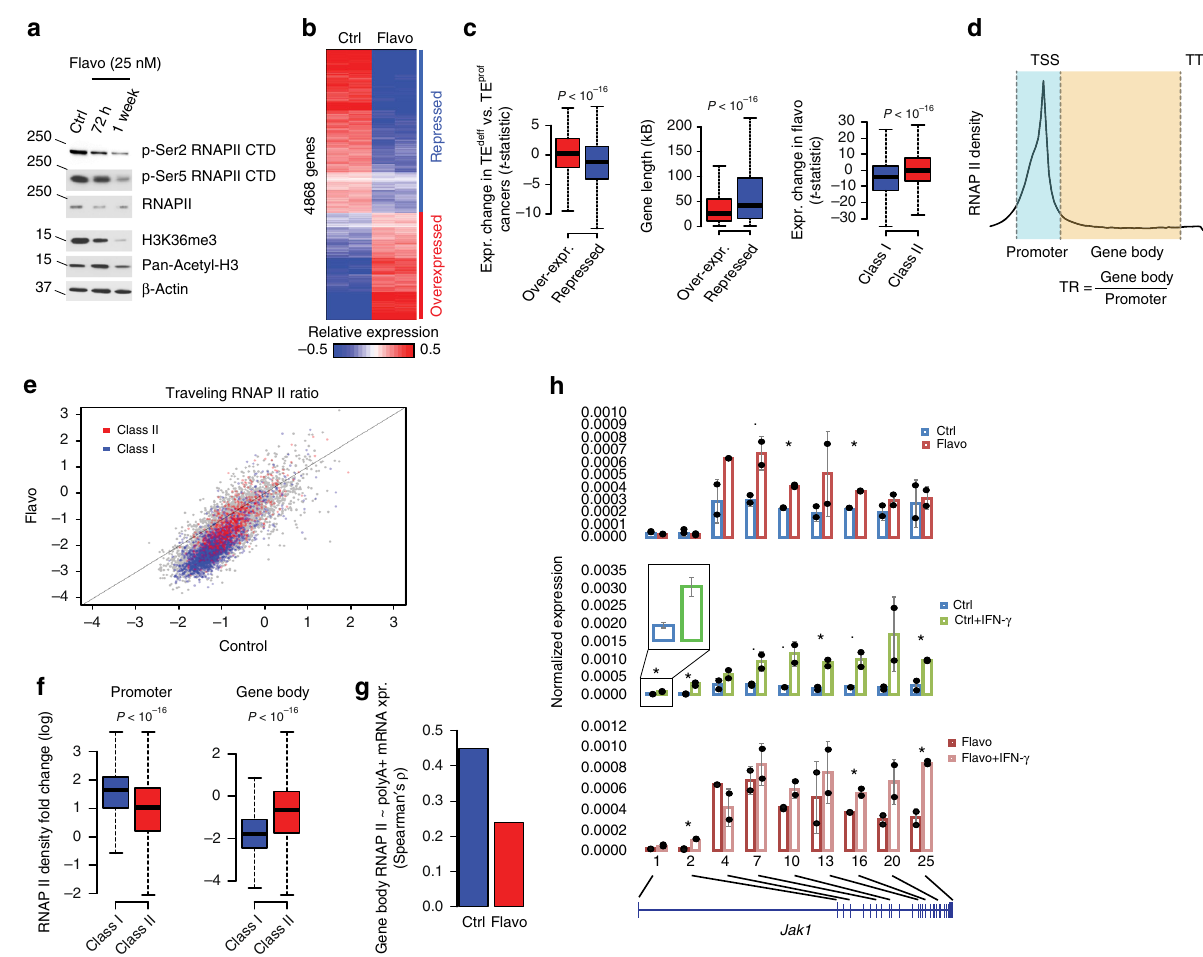
Fig. 6 Chronic inhibition of TE recapitulates TE deff . a Immunoblots of indicated histone and RNAP II marks in B16/F10 cells treated with fl avopiridol for 72 h or 1 week. b Heatmap of the differentially expressed genes (i.e. P < 0.05) in chronic (1 week) fl avopiridol-treated B16/F10 cells (log2 row normalized). c Expression change in TE deff vs. TE prof cancer tissues (left), and genomic lengths (middle), of repressed and over-expressed genes in fl avopiridol-treated cells, right) Expression change of Class I and Class II genes in fl avopiridol-treated cells. d Calculation of the traveling RNAP II ratio from total RNAP II ChIP- seq data, which is de fi ned as the ratio of occupancy of RNAP II along the gene bodies to that around the TSS. e Genome-wide comparison of RNAP II traveling ratio in the control and chronic fl avopiridol-treated B16F10 cells. Each point depicts a gene, and Class I and II genes are colored accordingly. f Log fold change in RNAP II occupancy in the promoter and gene body regions in chronic fl avopiridol-treated cells over control in Class I and II genes. g Spearman ’ s rank correlation of gene body RNAP II occupancy with overall polyA + mRNA expression (based on RNAseq data from b ) in the respective genes in the parental and fl avopiridol-treated B16F10 cells. h qPCR-based quantitation of expression of the indicated Jak1 exons in the parental and fl avopiridol-treated B16F10 cells with and without 2 h stimulation with IFN γ . Error bars re fl ect s.d. of duplicate measurements. Statistical signi fi cance of difference is coded: (.): P < 0.1, (*): P < 0.05 by T -test. Boxplots: middle line: median, boxed areas extend from the fi rst to third quartile; whiskers show 1.5x inter-quartile range from the fi rst (bottom) or third (top)